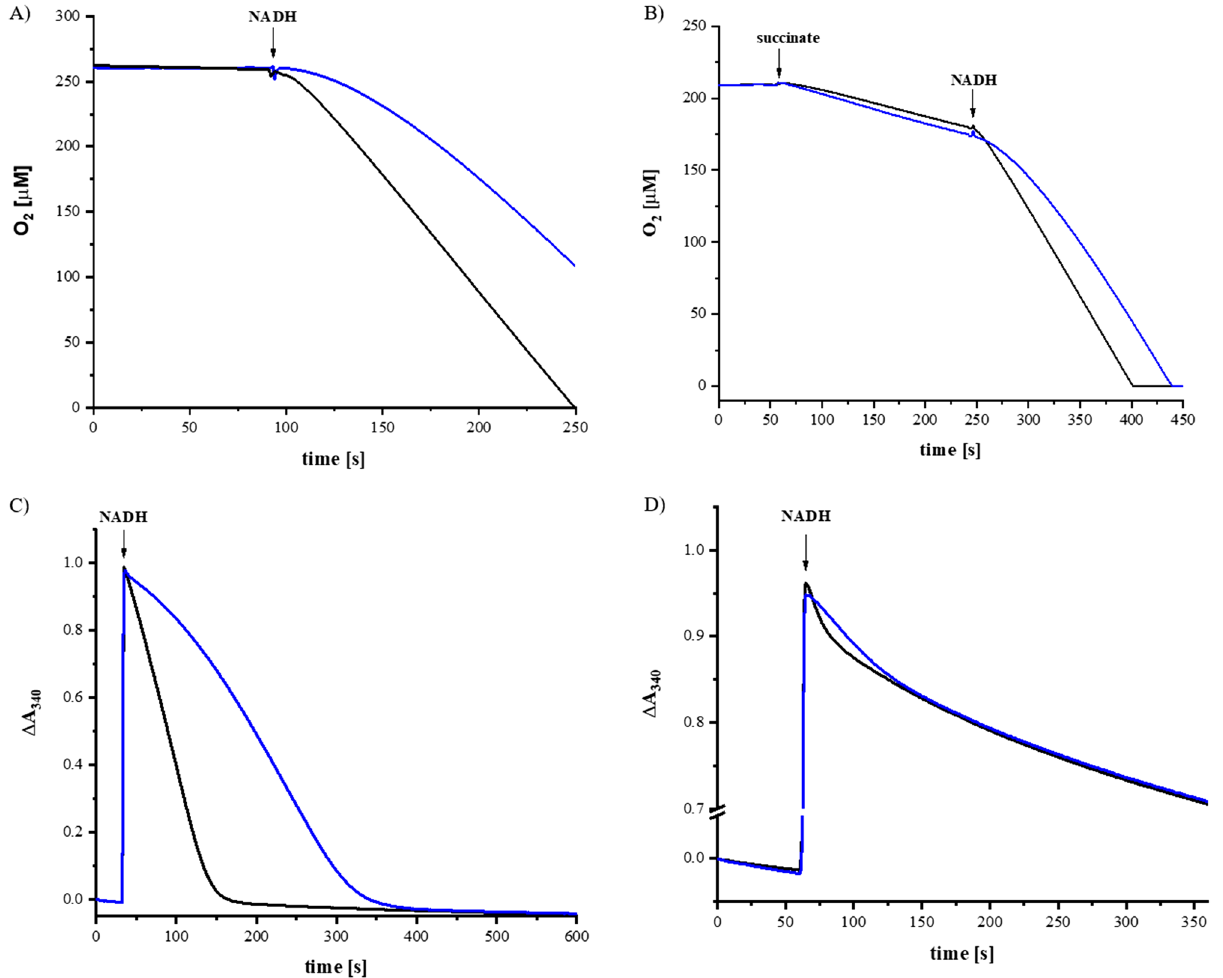
Figure 3. Activity of complex I (black) and the D213G H variant (blue). ( A ) NADH oxidase activity of the membranes, ( B ) NADH oxidase activity after partial reduction of the Q-pool by an addition of succinate (0.034 ± 0.001 U/mg protein). The maximum NADH oxidase activity of membranes from the wild type was 0.413 ± 0.018 U/mg protein and that of membranes from the D213G H mutant strain 0.194 ± 0.033 U/mg protein, ( C , D ) NADH:decyl-Q oxidoreductase activity of the preparations in the presence ( C ) and in the absence ( D ) of